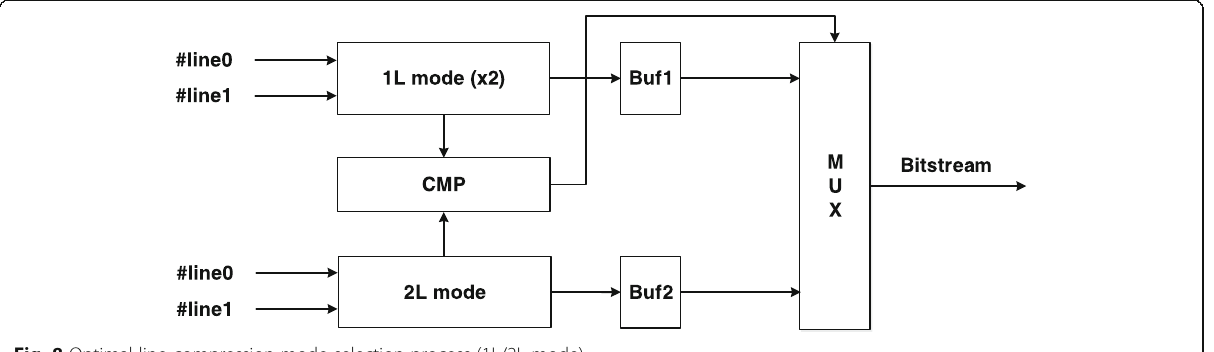
Fig. 8 Optimal line compression mode selection process (1L/2L mode)